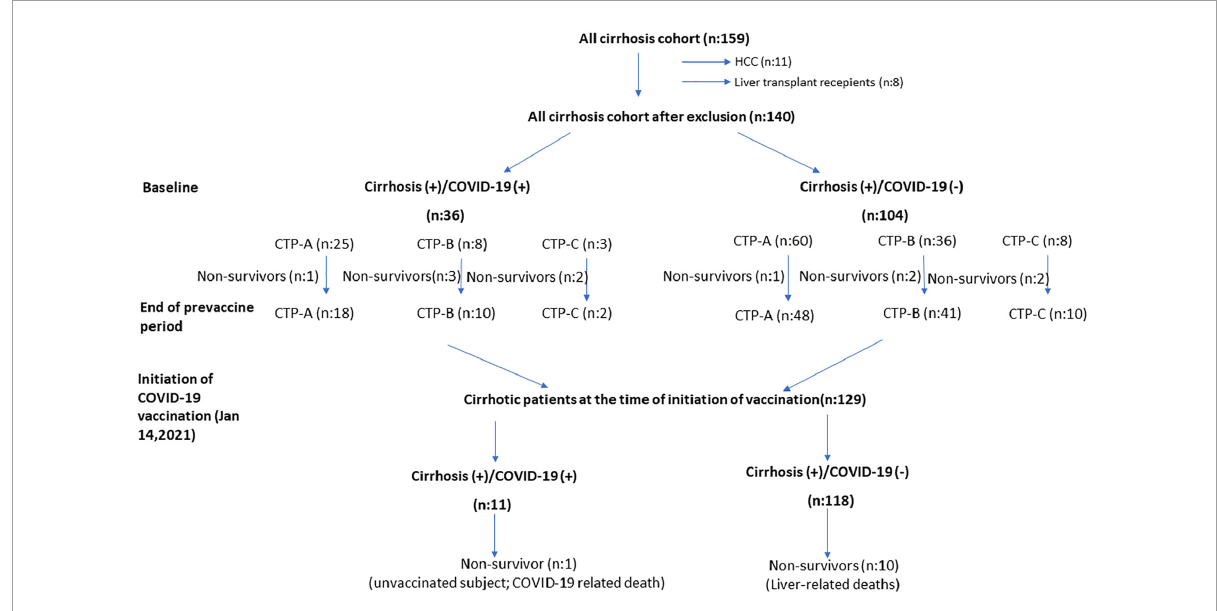
FIGURE1 The course of cirrhosis patients during the 10 months pre-vaccine and 10 months post-vaccination periods.